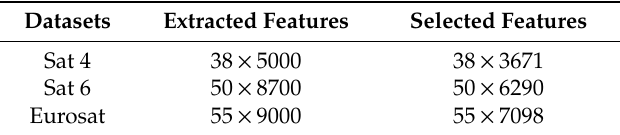
Table 3. Selected feature vectors after applying the feature selection algorithm.